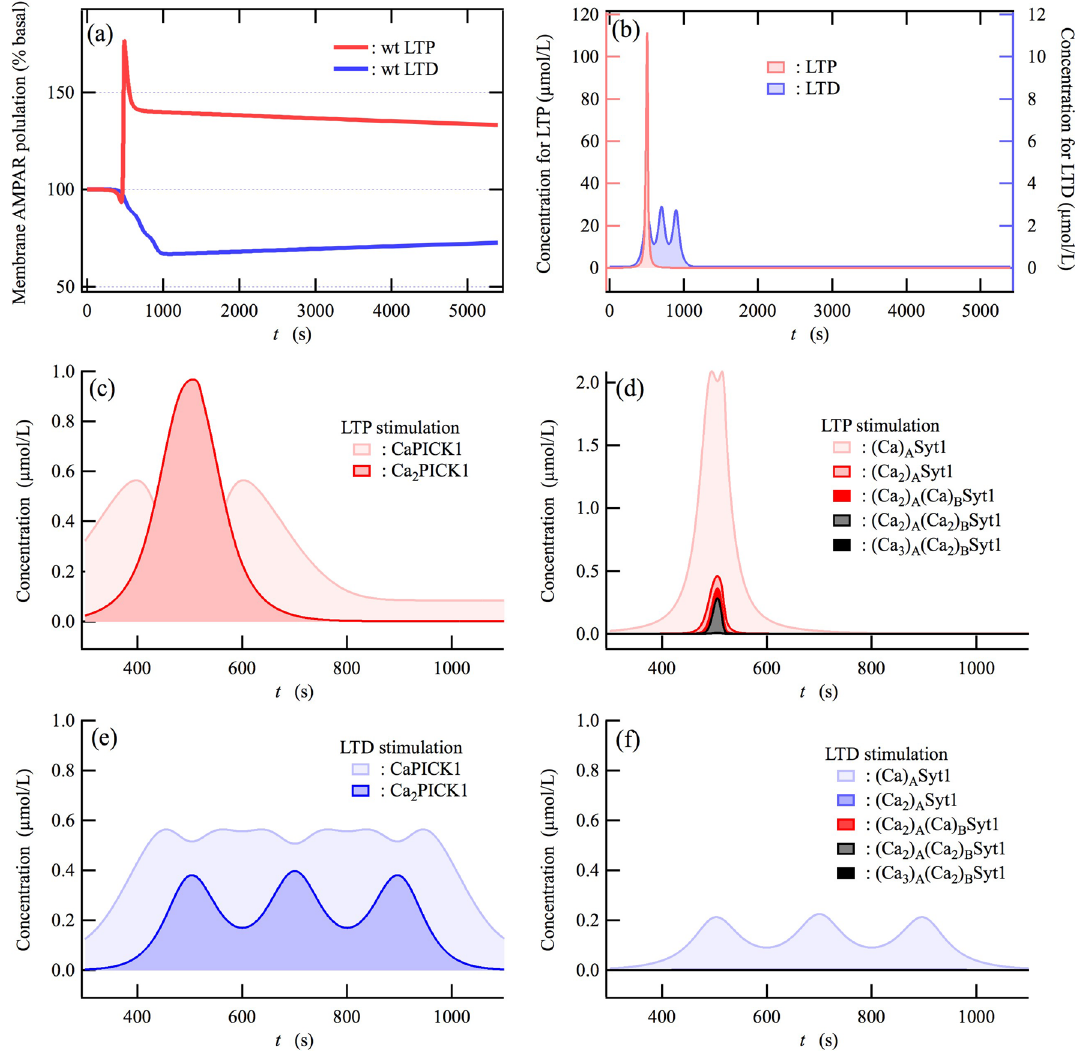
and LTD. Here, 100% represents the basal AMPAR population at the membrane. ( b ) Ca 2+ -pulse concentrations corresponding to the LTP and LTD stimulation are shown on the left and right axis, respectively. ( c – f ) The concentrations of Ca 2+ -binding species of PICK1 ( c,e ) and Syt1 ( d , f ) as a function of time ( t ) during LTP (c